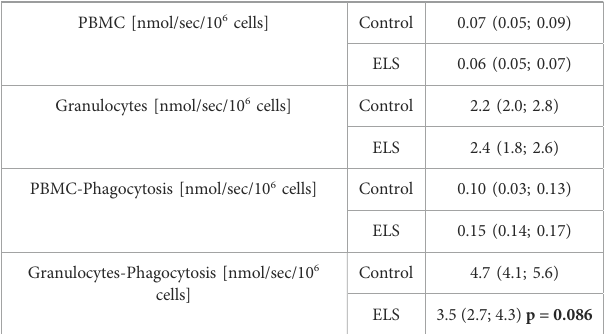
TABLE 6 Peripheral blood mononuclear cell (PBMC) and granulocyte (cid:129) (cid:1) ) production at baseline and after stimulation of superoxide anion (O 2 phagocytosis with E.coli in the control (n =5)and Early Life Stress (ELS) groups (n = 6). Data are median (interquartile range); the bold number refers to the p -value for intergroup